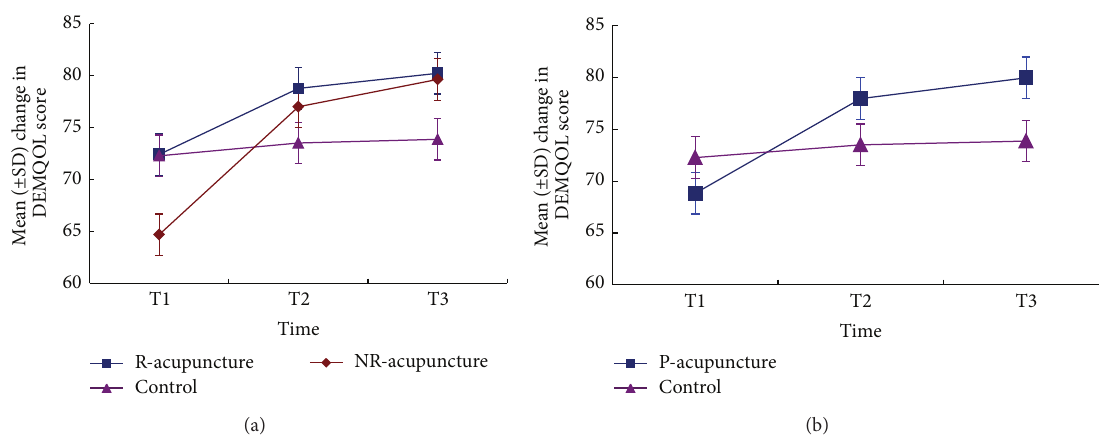
Figure 4: The changes of score in DEMQOL across time. Comparison among R-acupuncture group, NR-acupuncture group, and control group (a) and between pooled-acupuncture group and the control group (b). R-acupuncture = randomized acupuncture group, Control = control group, NR-acupuncture = nonrandomized acupuncture group, and P-acupuncture = pooled-acupuncture group. T1 = at baseline, T2 = after 6-week treatment, and T3 = after 4-week